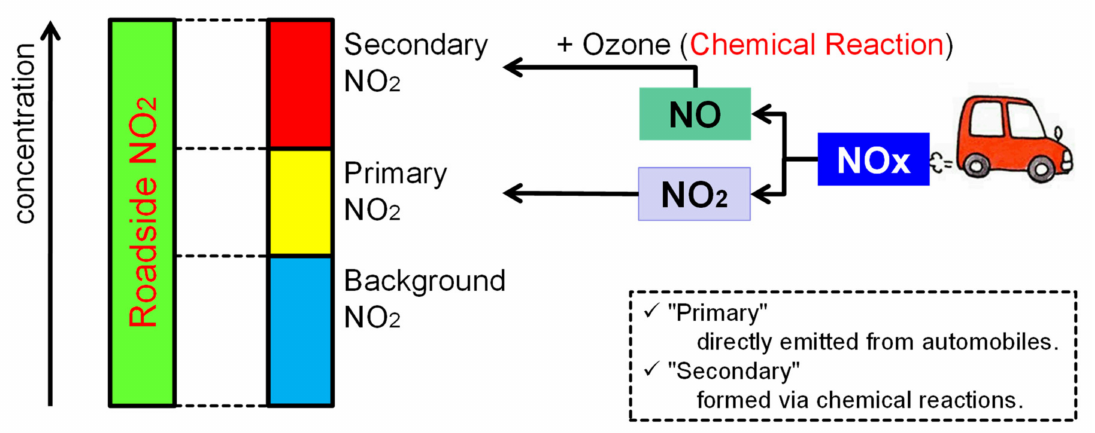
Figure 20. Roadside NO 2 estimation process.